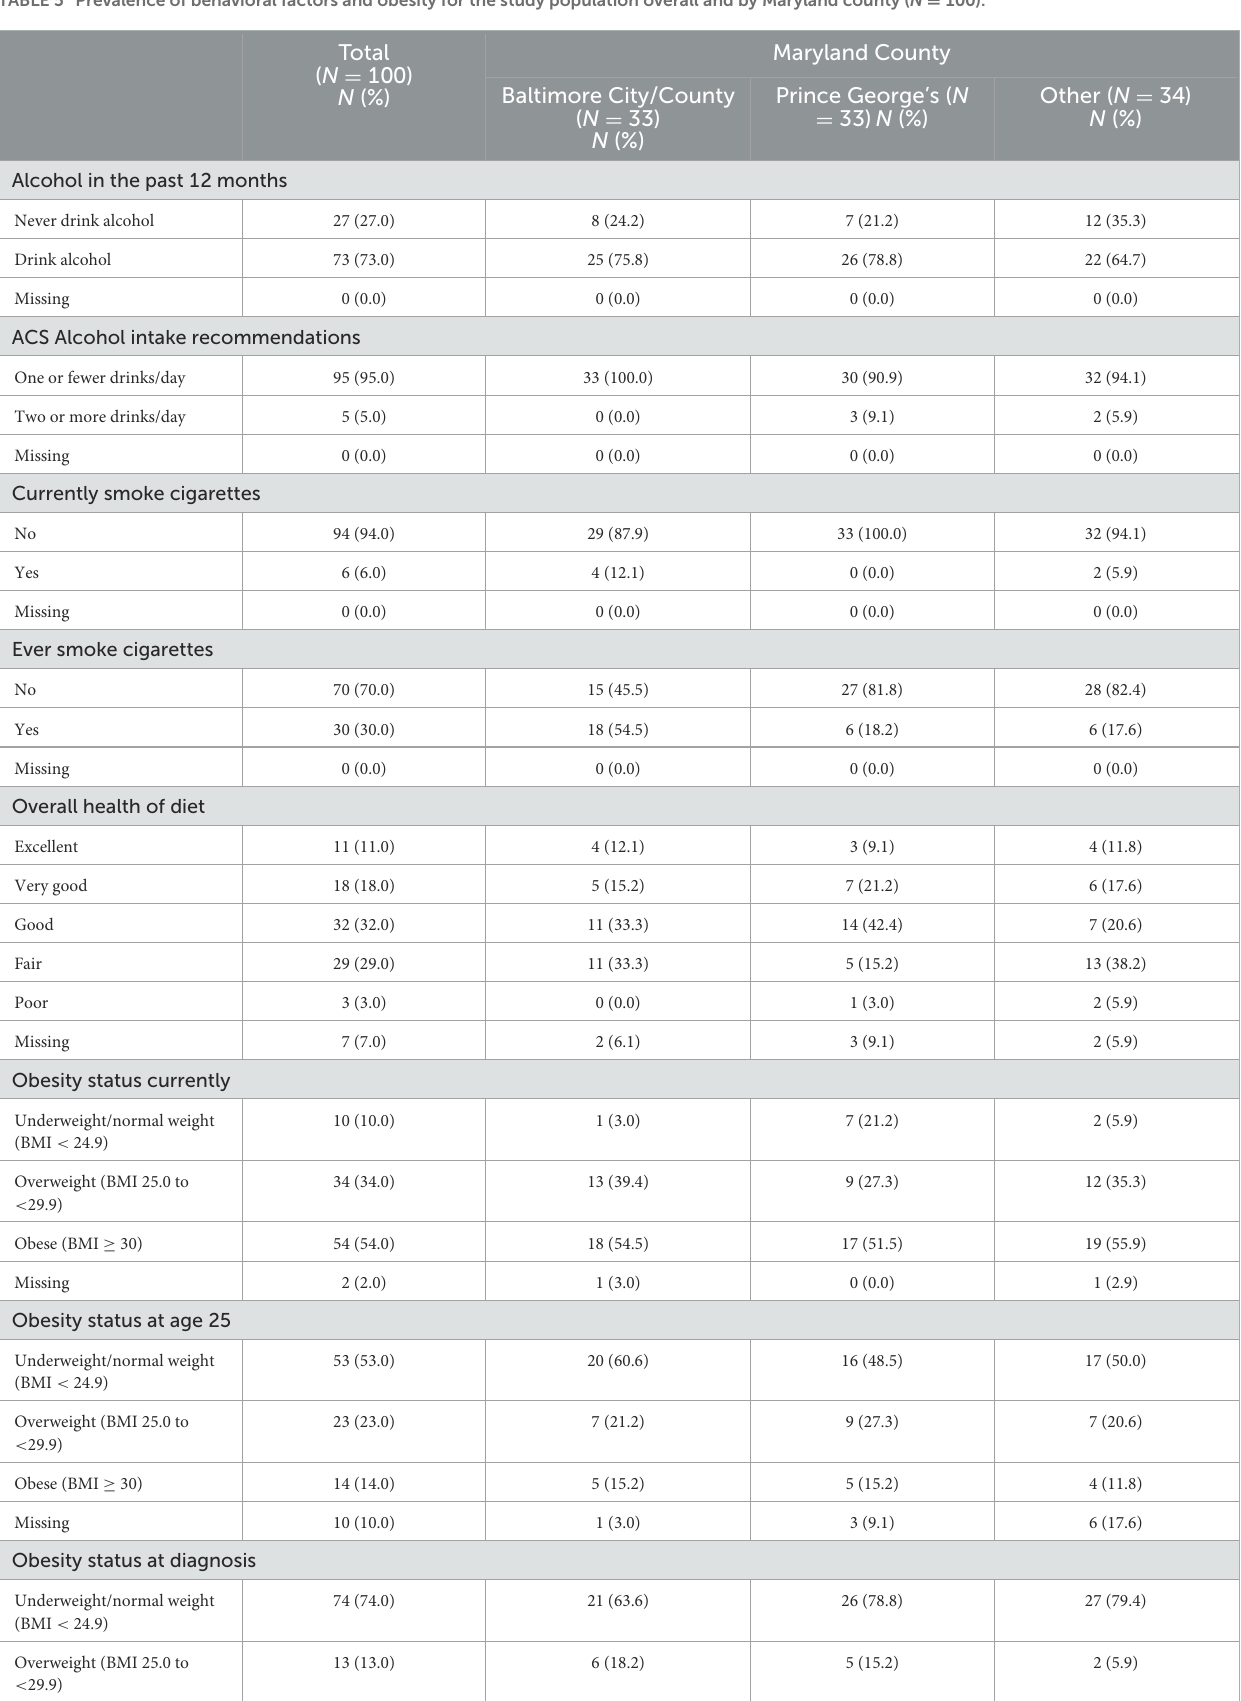
TABLE 5 Prevalence of behavioral factors and obesity for the study population overall and by Maryland county ( N =